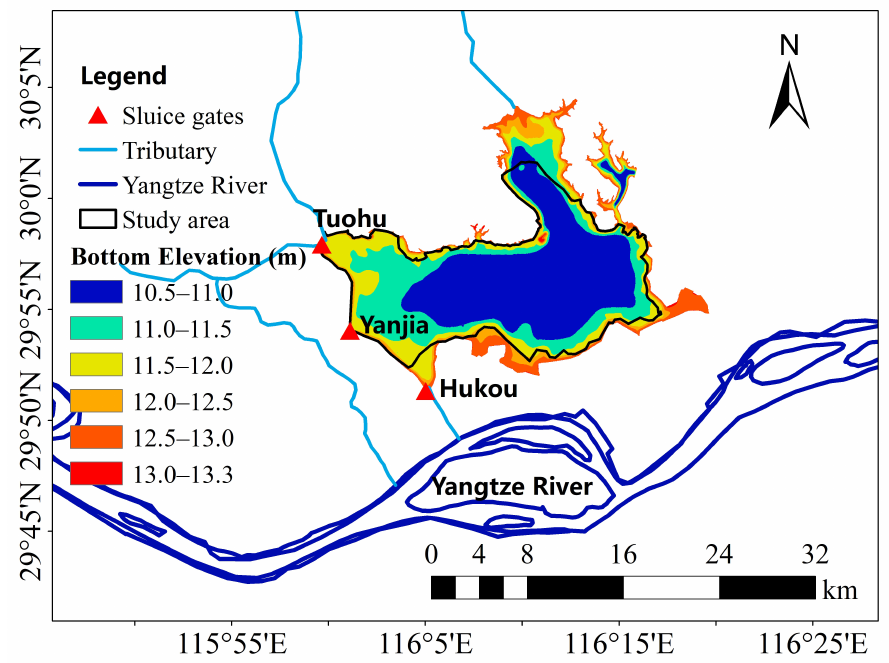
Figure 1. Location of Longgan Lake. The elevation of the lake bottom ranges between 10.5 m and 13.3 m (meters above sea level, reference to Wusong